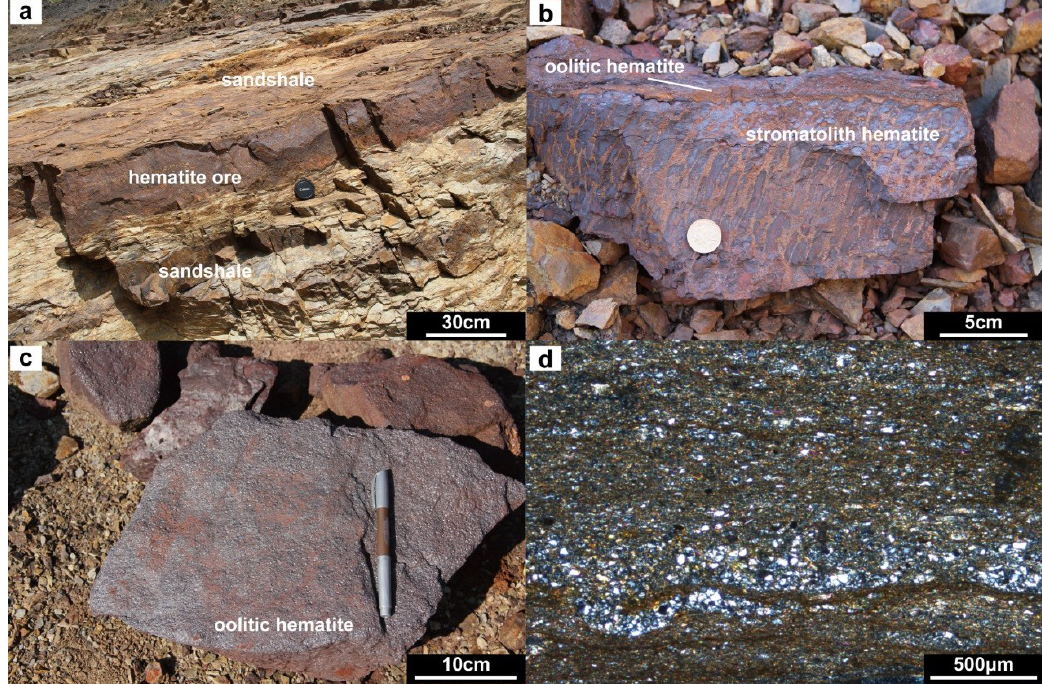
Figure 3. ( a ) Outcrop photo of the sandy shale; ( b ) photo of the stromatolith hematite ore with oolitic hematite appearing at the top; ( c ) photo of the oolitic hematite ore; ( d ) micrograph of the sandy shale.